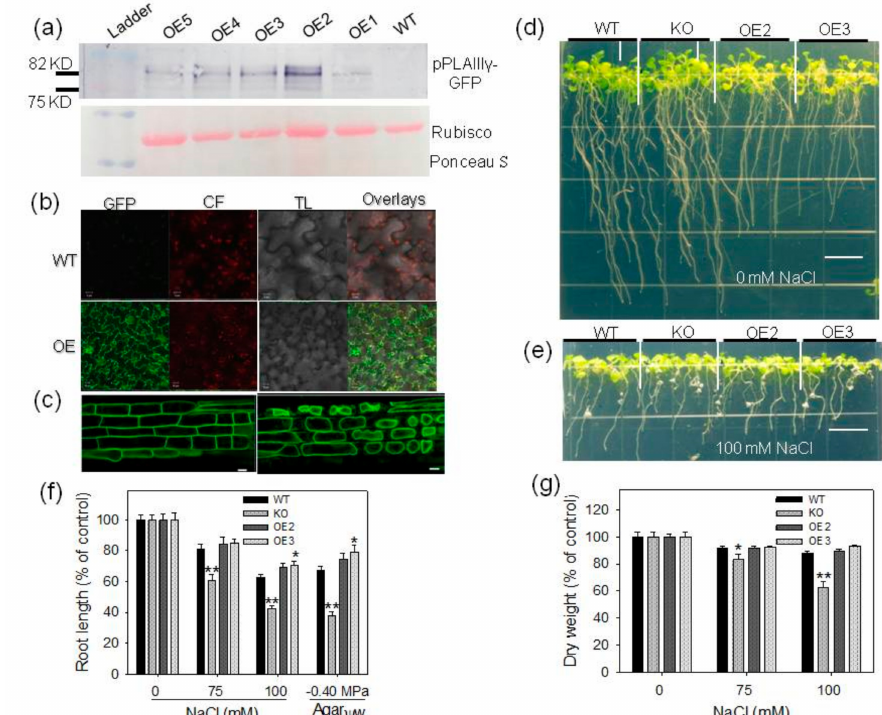
Figure 3. Opposite effects of pPLAIII γ - KO and -OE lines on tolerance to NaCl and PEG; ( a ) Immunoblotting of GFP-His-tagged pPLAIII γ in Arabidopsis . Five independent homozygous lines of pPLAIII γ -OEmutantswereexamined; ( b )confocalimagesofepidermalcellsofWTand pPLAIII γ -OE:GFP leaves and chlorophyll fluorescence versus GFP; ( c ) plasmolysis of root epidermal cell of the pPLAIII γ -OE:GFP. Representative images of WT, KO and OE lines without ( d ) or with ( e ) NaCl stress; ( f ) relative growth of root length of WT, KO and OE lines. Values are mean ± SE ( n = 45–60); ( g ) relative growth of dry weight of WT, KO and OE lines. Values are mean ± SE from three biologic repeats for each line (20 seedlings dry weight per biologic repeat). One and two asterisks indicate significant differences from WT by Student’s t-test at p = 0.05 and p = 0.01,